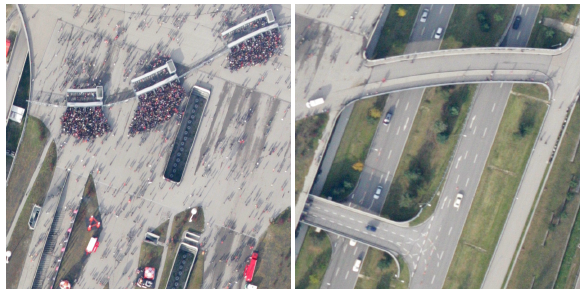
Figure 1. Sample frames from the vehicle and person tracking sets of the KIT AIS